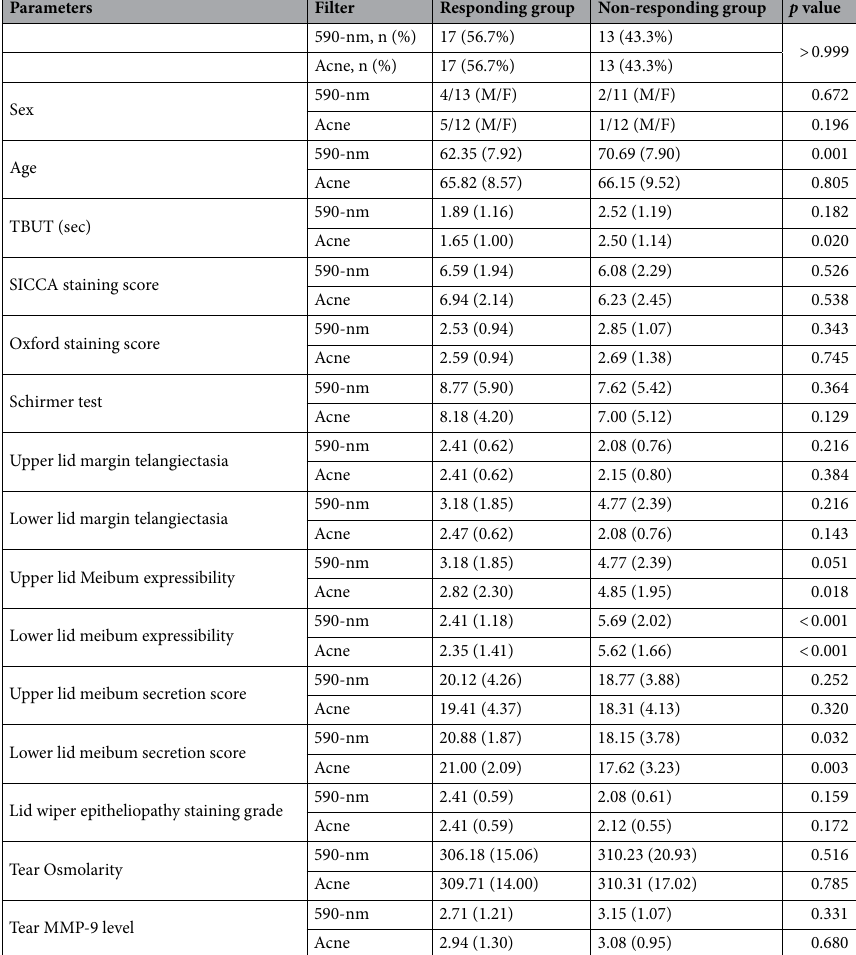
Table 4. Comparison of clinical parameters between acne and 590-nm filters in the responding and non- responding groups. Results are presented as mean (standard deviation). IPL, intense pulsed light;